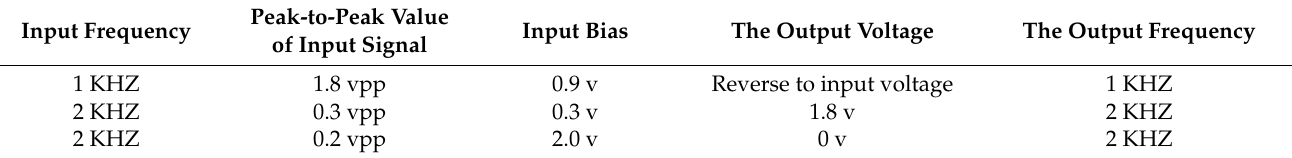
Table 6. Integrated circuit test results.